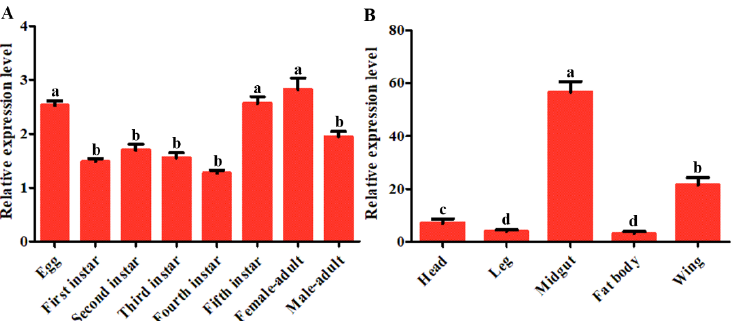
Figure 3. The spatiotemporal expression patterns of DcTPS1 in different developmental stages ( A ) and different tissues ( B ) of Diaphorina citri . Relative expression levels of DcTPS1 were analyzed using qPCR. Data were normalized using glyceraldehyde-3-phosphate dehydrogenase ( GAPDH ) and are represented as the means ± standard errors of the means from three independent experiments. The 2 - ∆∆ Ct method was used to calculate the relative expression level. Statistical analysis was conducted using SPSS software. Different letters indicate significant differences, for example, a, b, c and d ( p < 0.05).